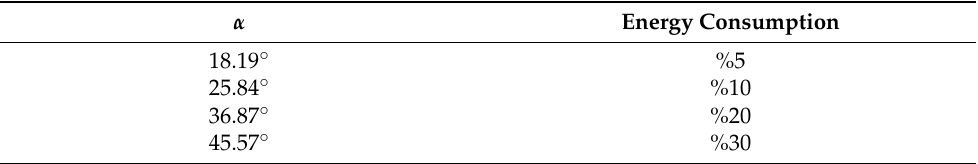
Table 2. Relation between energy consumption and α angle.